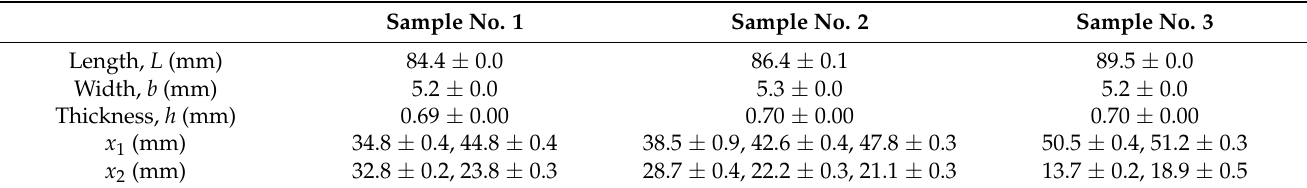
Table 1. Dimensions of prototype SMA FS (average ± standard deviation from ten measurements).